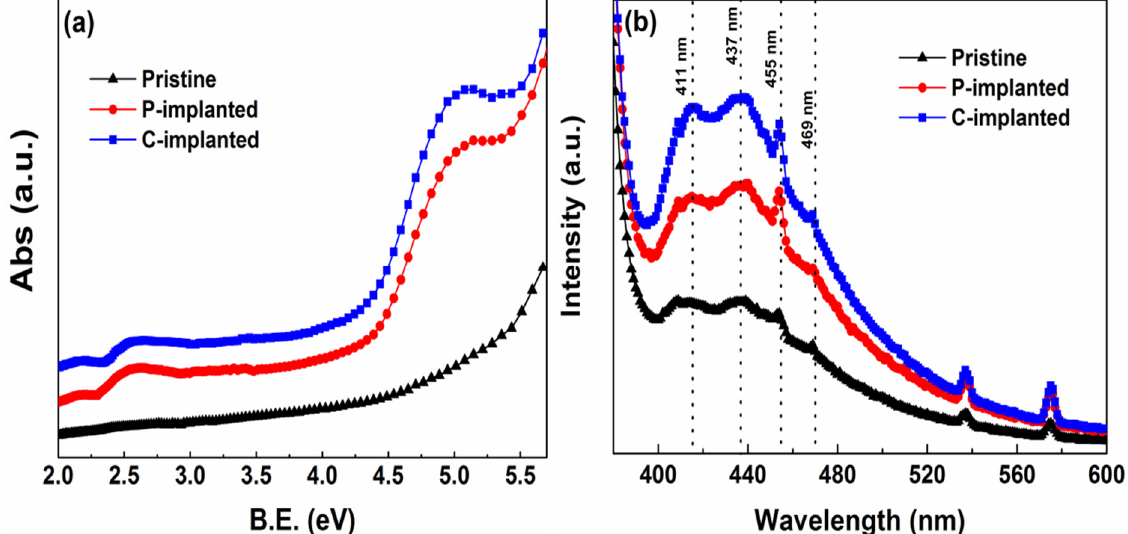
Figure 5. ( a ) Absorption spectrum and ( b ) PL spectrum of pristine, C-implanted, and P-implanted MgO samples.